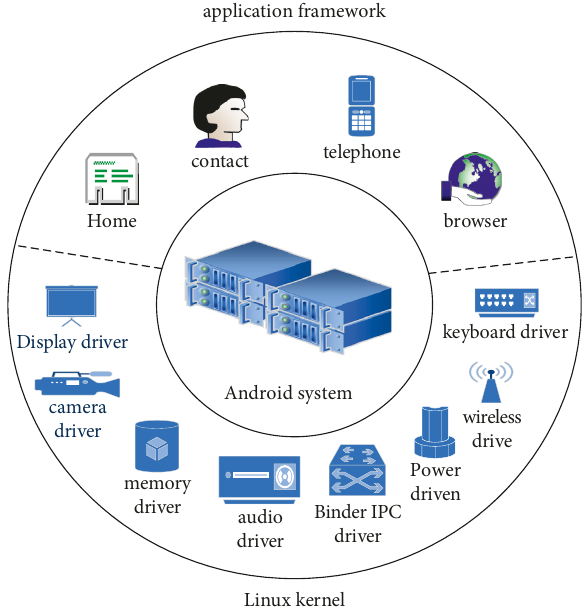
Figure 2: Android system architecture